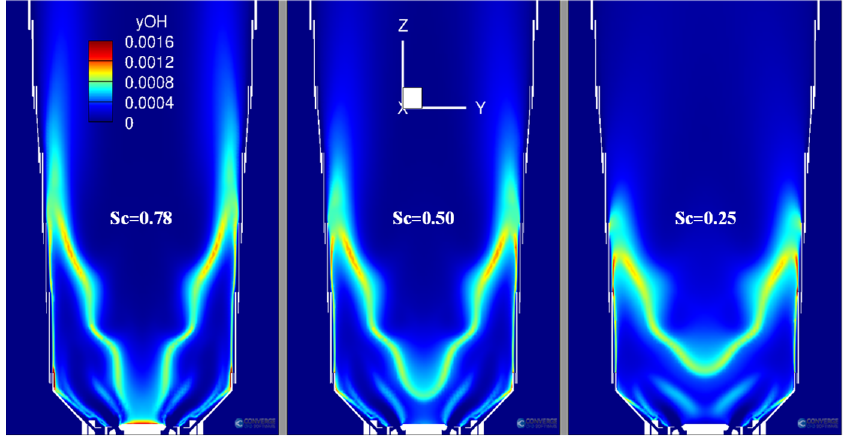
Figure 7. Sensitivity study over the turbulent Schmidt number—Duino case.